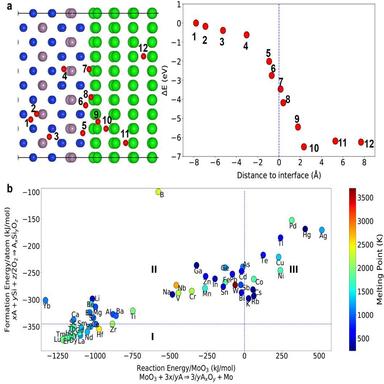
(a) The relationship between the position of interstitial oxygen and relative energy. The energy of Oint in bulk-like MoSi2 is set as a zero reference. (b) Two descriptors: silicate formation energy and oxygen exchange reaction energy, are used to assess the viability of 55 elements as getter materials. The regions are labeled as follows: I: oxygen exchange reaction favored and silicate formation energy is lower than Zr; II: oxygen exchange reaction favored and silicate formation energy is higher than Zr; I